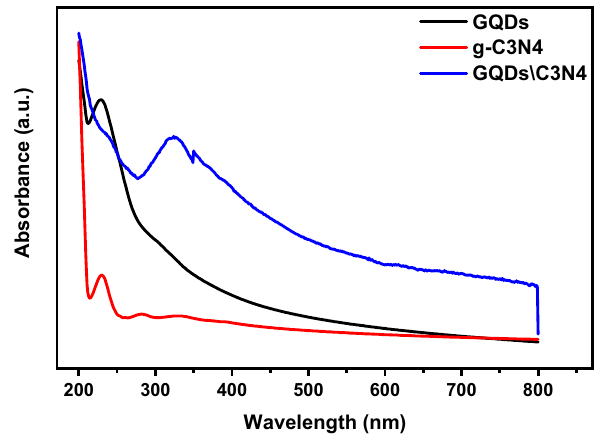
Figure 11. The UV–Vis absorbance of prepared materials.